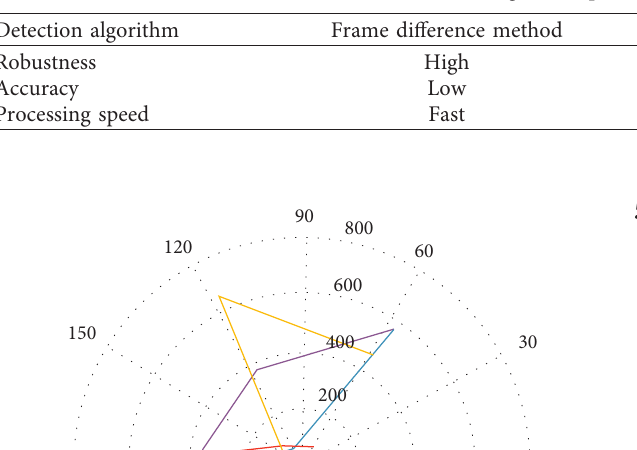
Table 3: Algorithm performance comparison.